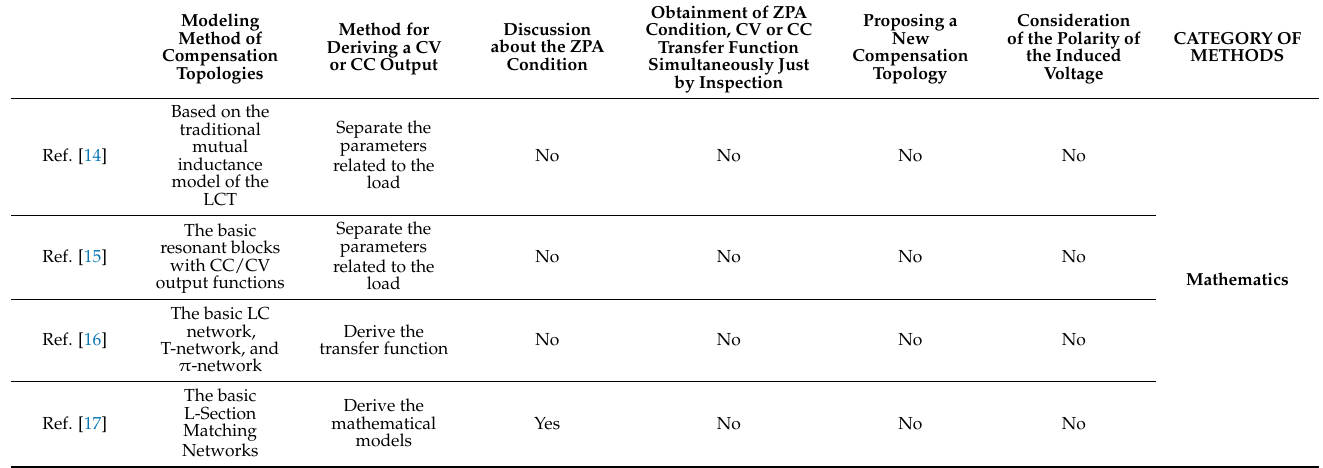
Table 6. Comparison with previous